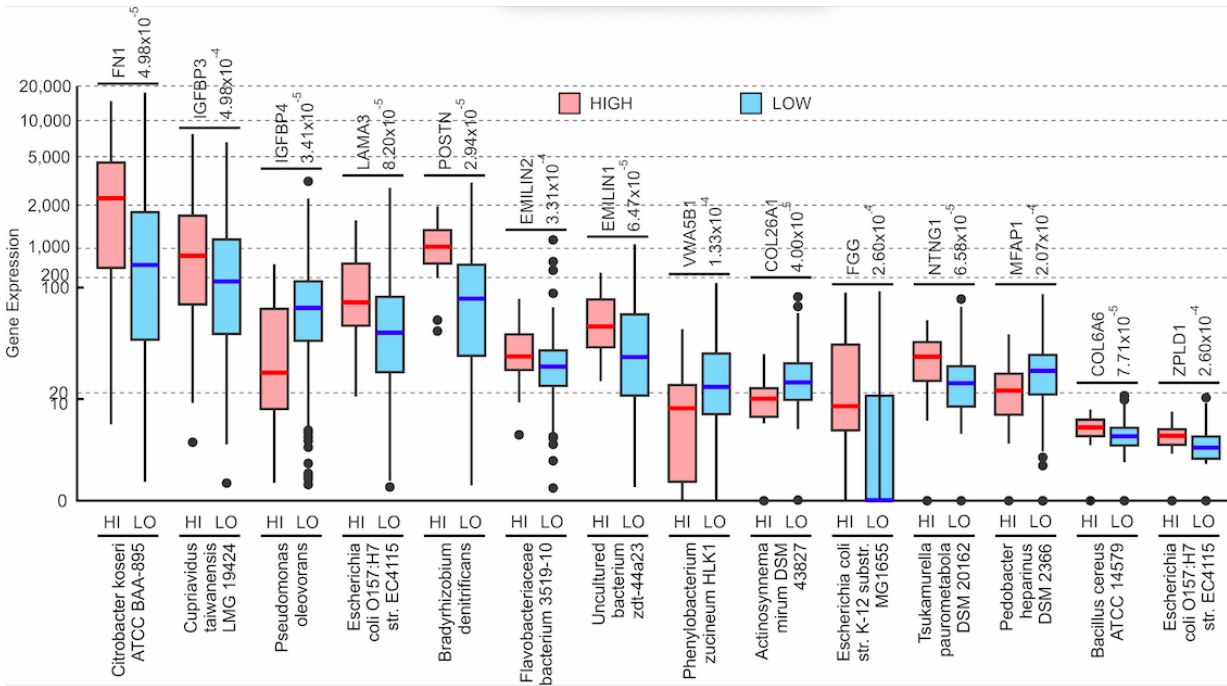
Figure 2. Microbe association with the ECM protein coding genes. Boxplots of specific ECM protein coding gene expression vs. microbial abundance (Kruskal–Wallis test, p < 0.05). Dots in the boxplots represent outliers. The cut-off value between high and low microbe abundance for each microbe is listed above the plot for each microbe, beside the name of the gene that the specific microbe is being correlated to. Although these cut-off values were determined from the mean abundance of each microbe across all samples, the values essentially discerned between the presence and the absence of a microbe within a sample.